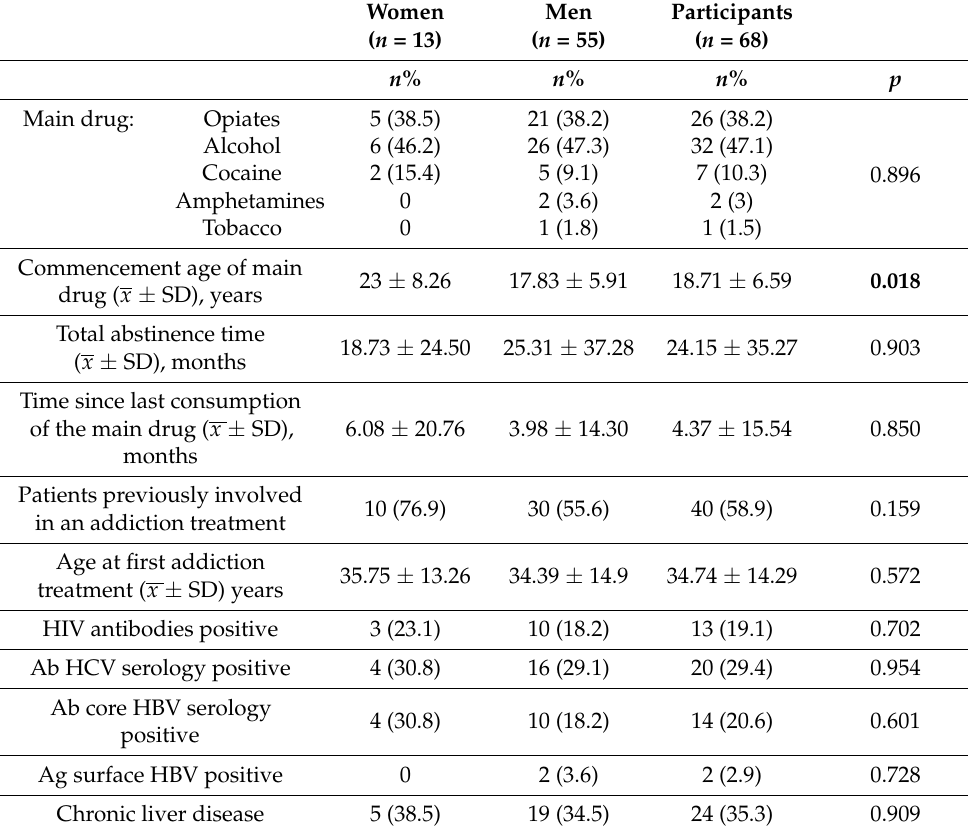
Table 2. Clinical characteristics of the sample, stratified by